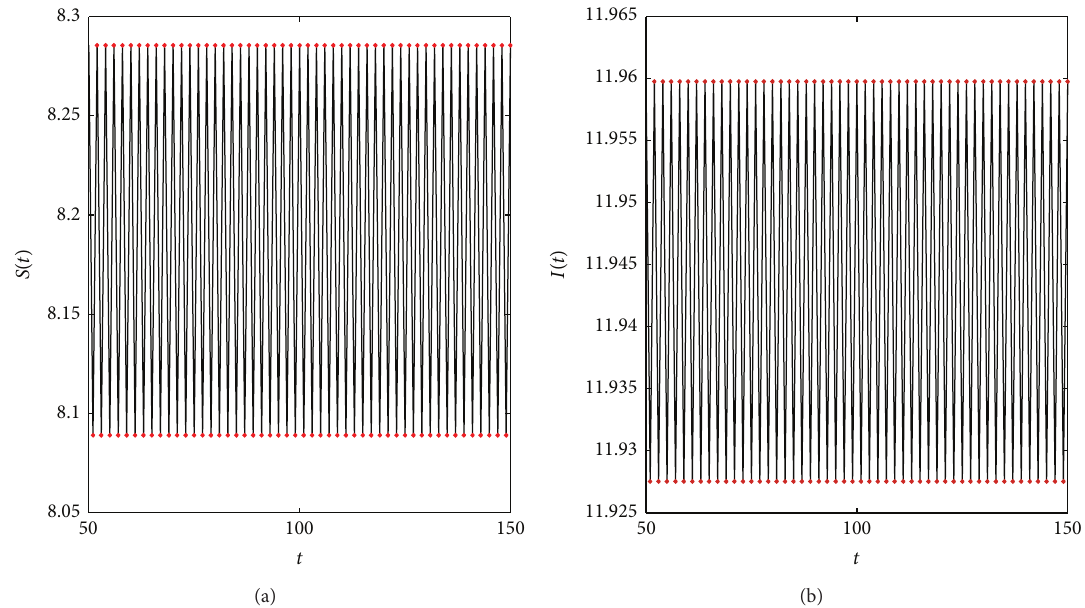
Figure 2: Dynamical behavior of system (2) with 𝜆(𝑡) = 10 , 𝛼(𝑡) = 0 , 𝛽(𝑡) = 0.1 , 𝜇(𝑡) = 0.0001 , 𝜀(𝑡) = 𝛾(𝑡) = 0.8 , 𝑇 = 𝜔 = 1 , 𝜃 1 = 0.1 , and (𝜔)) ≃ 1.1527 . (a) Time series of 𝑆(𝑡) . (b) Time series of 𝐼(𝑡) . 𝑟(Φ 𝐹−𝑉